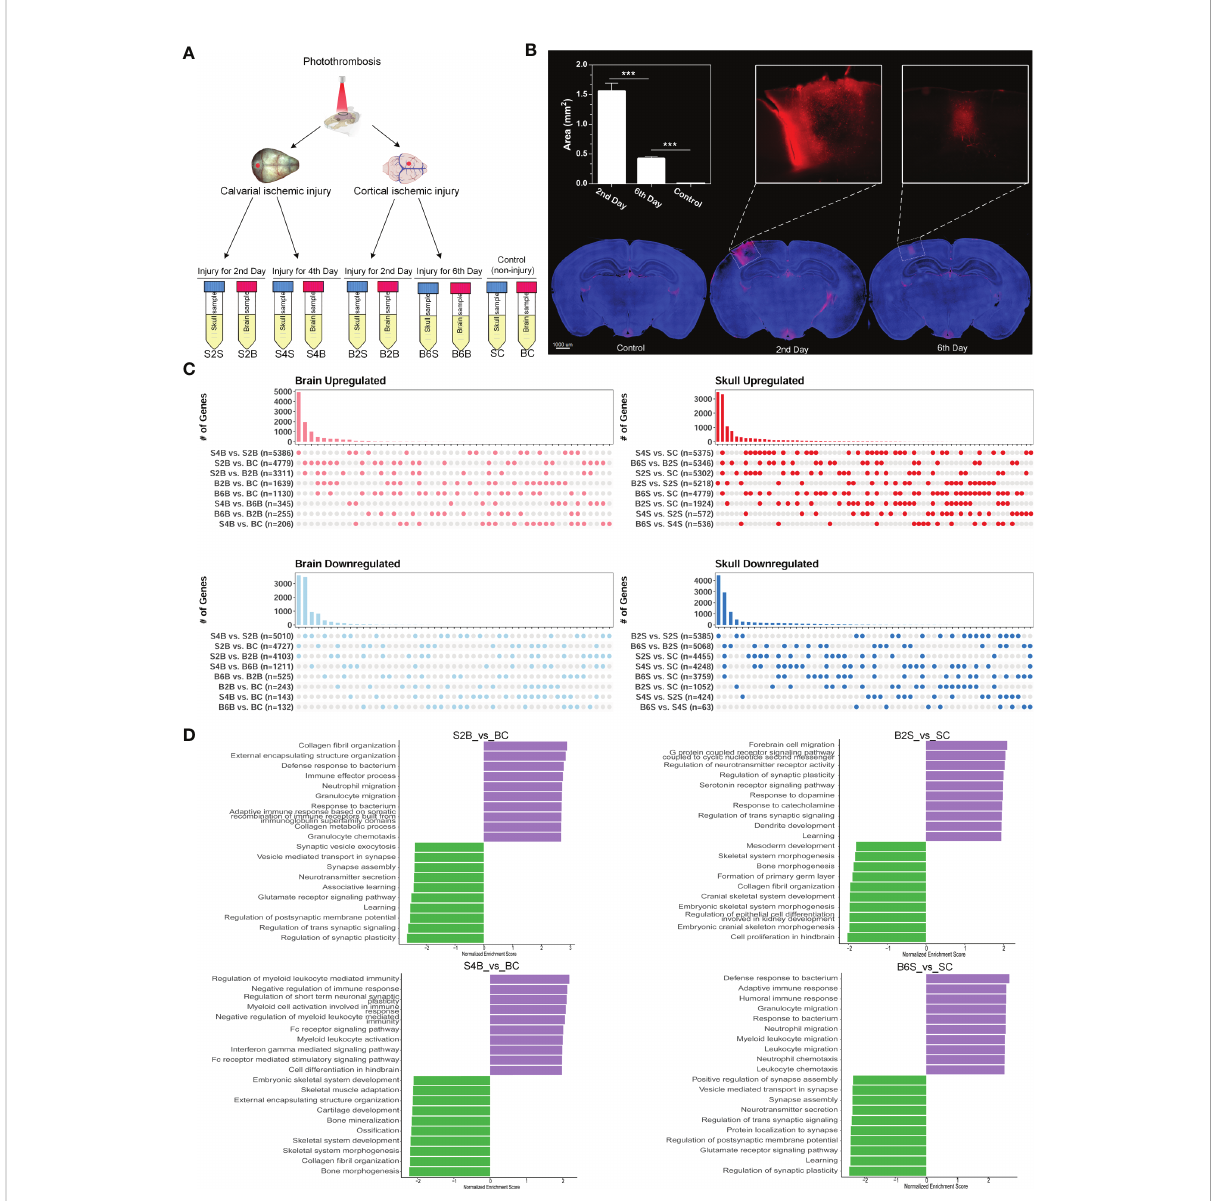
FIGURE 1 Experimental design and transcriptome analysis of the brain and skull after photothrombosis (PT). (A) Experimental design of the brain and skull PT. BC , control group for the uninjured brain; B2B and B6B , brain samples of the second and the sixth day after brain PT; SC , control group for the uninjured skull; S2S and S4S , skull samples of the second and the fourth day after skull PT; B2S and B6S , skull samples of the second and the sixth day after brain PT; S2B and S4B , brain samples of the second and the fourth day after skull PT. (B) Rhodamine extravasation evaluating the degree of brain injury at different time points after brain PT ( n = 3, mean ± standard deviation). *** p < 0.001. (C) Number of up- and downregulated genes between the brain and the skull groups. (D) Gene set enrichment analysis (GSEA) of brain and skull ischemic injury with adjusted p -values less than 0.05 (top 10 up- and downregulated